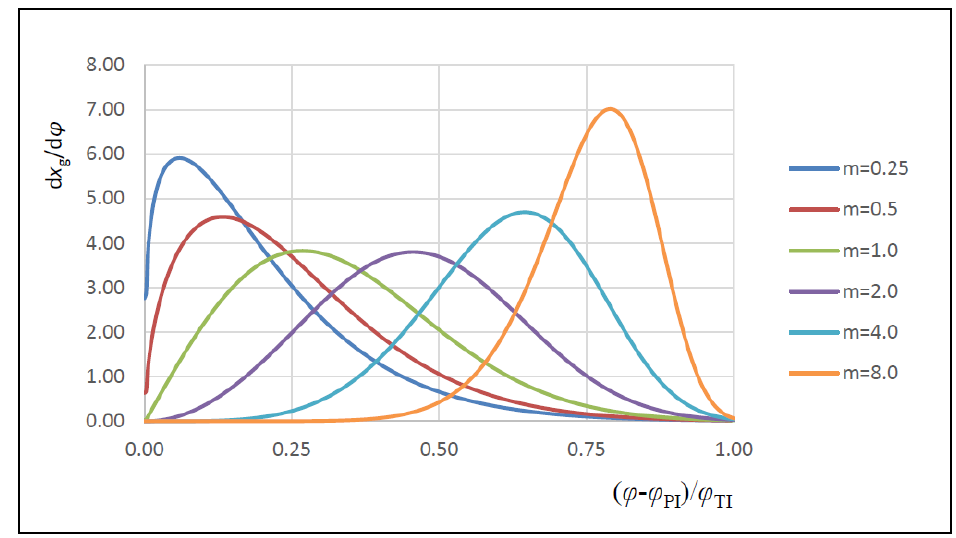
Figure 2. Combustion rate as a function of crank angle, for different Vibe exponents, m [21,22].